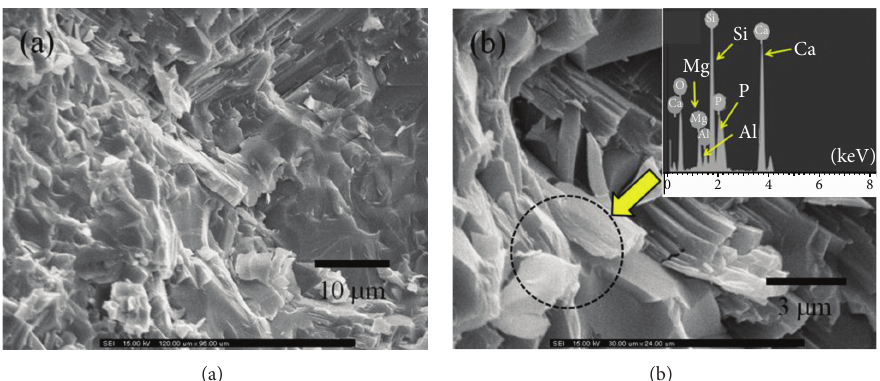
Figure 5: Surface microstructure of AW based glass sintered at 1100 ∘ C for 2 h, before SBF immersion. (a) Low magnification, scale bar 10 𝜇 m. (b) High magnification, scale bar 3 𝜇 m.